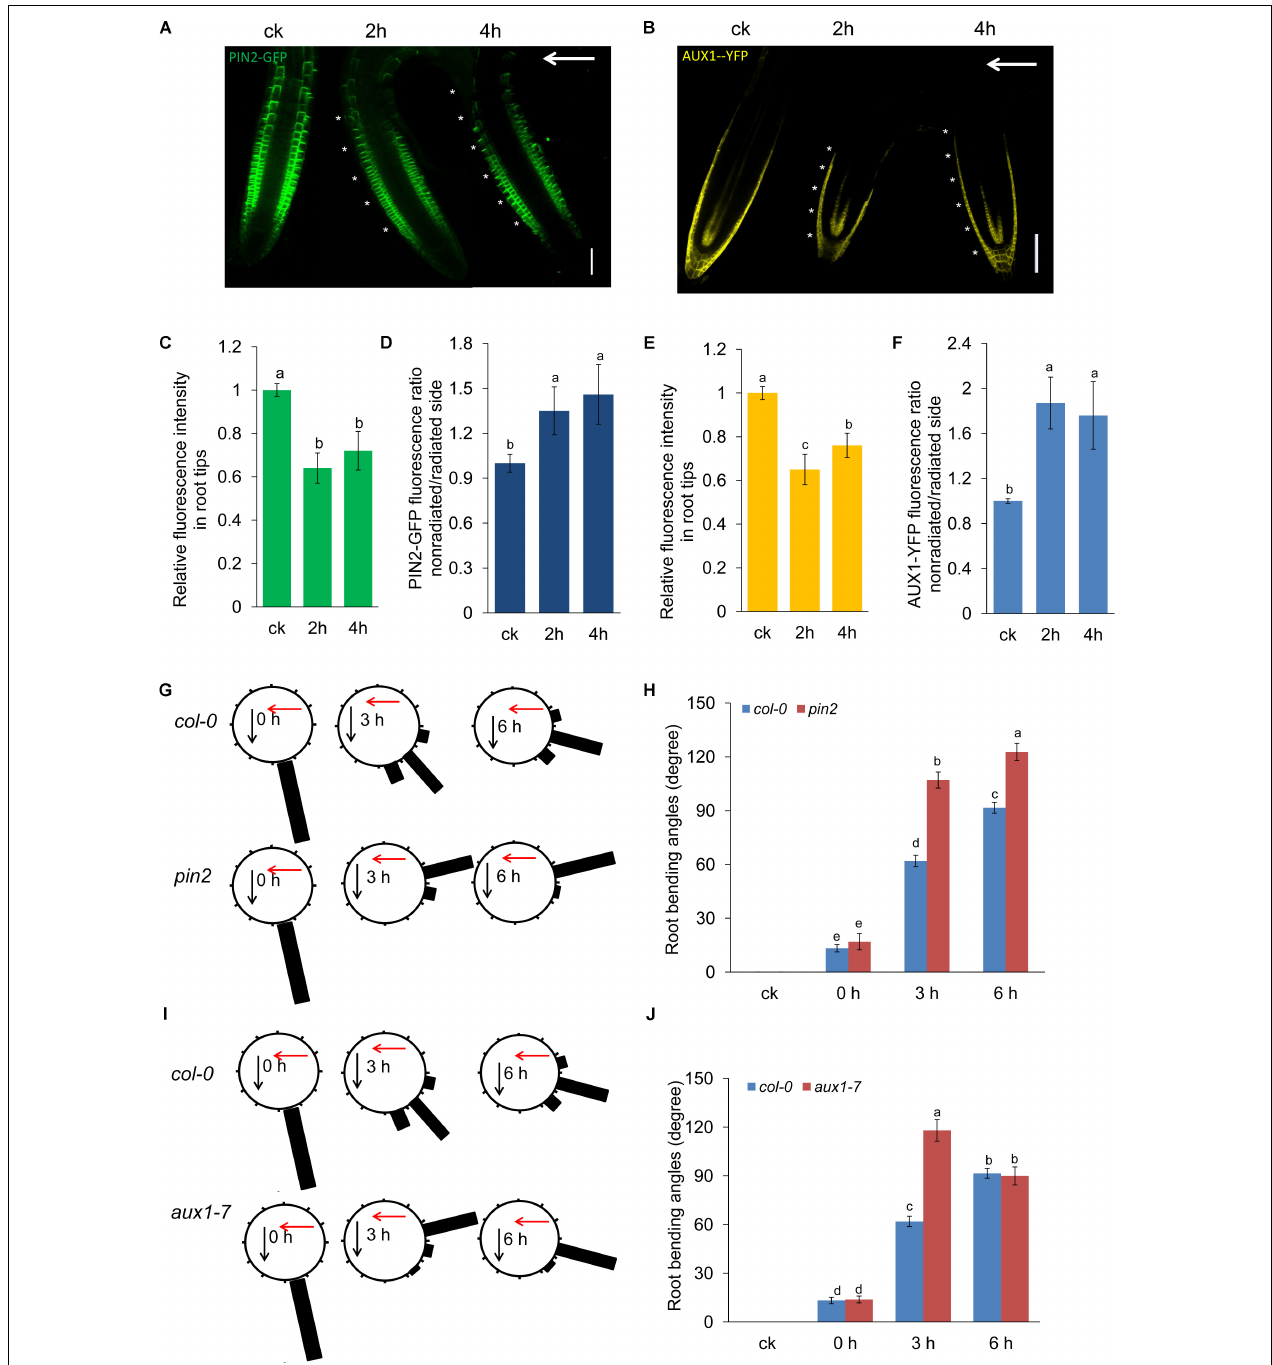
FIGURE 5 | PIN2 and AUX1 are involved in UV-B-induced root bending. GFP/YFP fluorescence in the roots of 5-d-old PIN2:GFP (A) or AUX1:YFP (D) seedlings exposed to UV-B radiation for 1 h and then transferred to normal growth conditions for 2 and 4 h, quantification of PIN2:GFP (B) or AUX1:YFP (E) fluorescence intensities in root tips and ratios of PIN2:GFP (C) or AUX1:YFP (F) signals in the root tip on the nonradiated side versus the radiated side are presented. Bars, 50 µ m. White arrows indicate the direction of UV-B radiation. White asterisks indicate more pronounced PIN2:GFP (A) or AUX1:YFP (D) signals on the nonradiated side of roots. (G–I) The angle of root bending of Col-0 , pin2 (G,H) , and aux1-7 (I,J) seedlings irradiated with UV-B for 1 h and then transferred to normal growth conditions for 0–6 h. Col-0 , n = 60; pin2 , n = 60; aux1-7 , n = 60. (G,I) Each gravistimulated root was assigned to 1 of the 12 30 ◦ sectors on a gravitropism diagram. The length of each bar represents the mean percentage of seedlings assigned to the respective sector. The red and black arrows indicate the direction of UV-B radiation and gravity, respectively. (H,J) The average root bending angles of Col-0 , pin2 (H) , and aux1-7 (J) seedlings; ck, before UV-B radiation control. The error bars represent the ± SE, and different letters indicate significantly different values ( P < 0.01 by Tukey’s test).